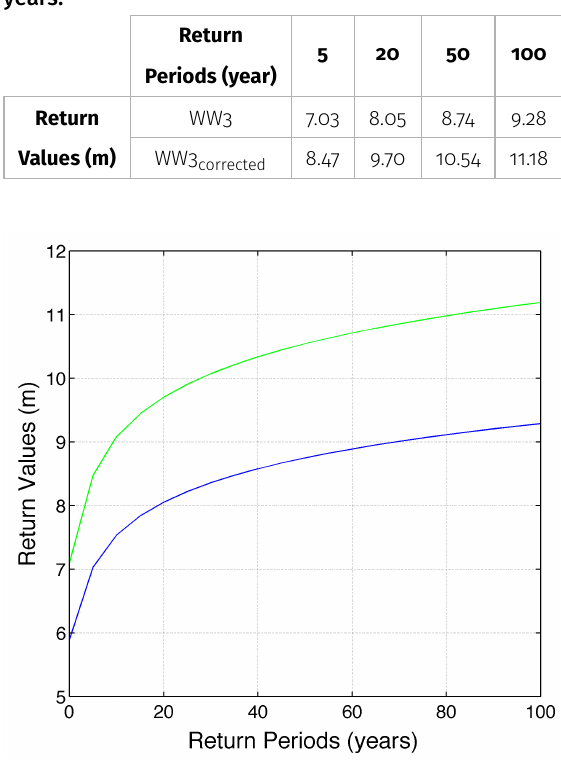
Table V. Return values for periods of 5, 20, 50 and 100 years.